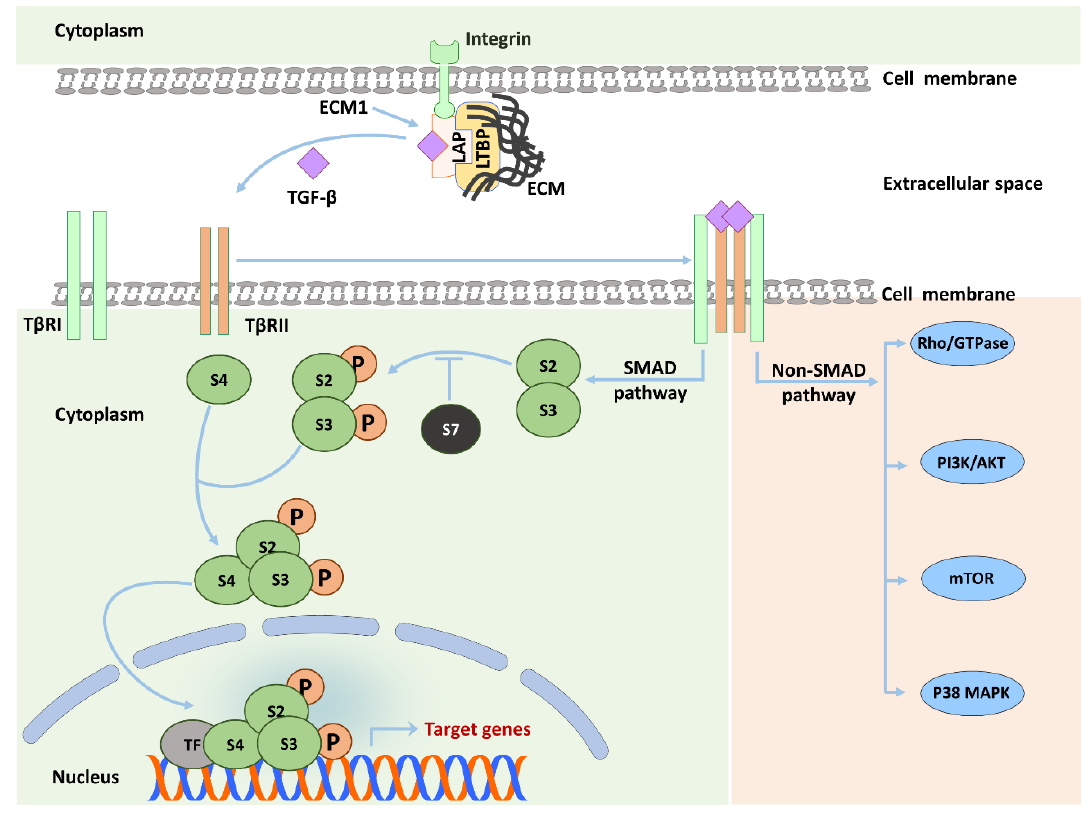
Figure 2. SMAD- and Non-SMAD-dependent TGF-β signaling. Upon liver damage associated signaling, TGF-β molecules are freed from the large latent complex (LLC) through the interaction of integrins with the latent association protein (LAP). Binding of released TGF-β to TβRII results in the formation of a heterotetramer with TβRI, which then initiates the canonical signaling pathway through phosphorylation of R-SMADs, i.e., SMAD2 (S2) and SMAD3 (S3). TGF-β can also activate non-canonical SMAD-independent pathways, as exemplified here by MAPK, mTOR, PI3K/AKT, and Rho/GTPase pathways. Alongside other mechanisms, SMAD7 negatively regulates TGF-β signaling through competing with R-SMADs for TβRI binding. TF: Transcription factors, P: phosphate group, LTBP: latent TGF-β binding protein.